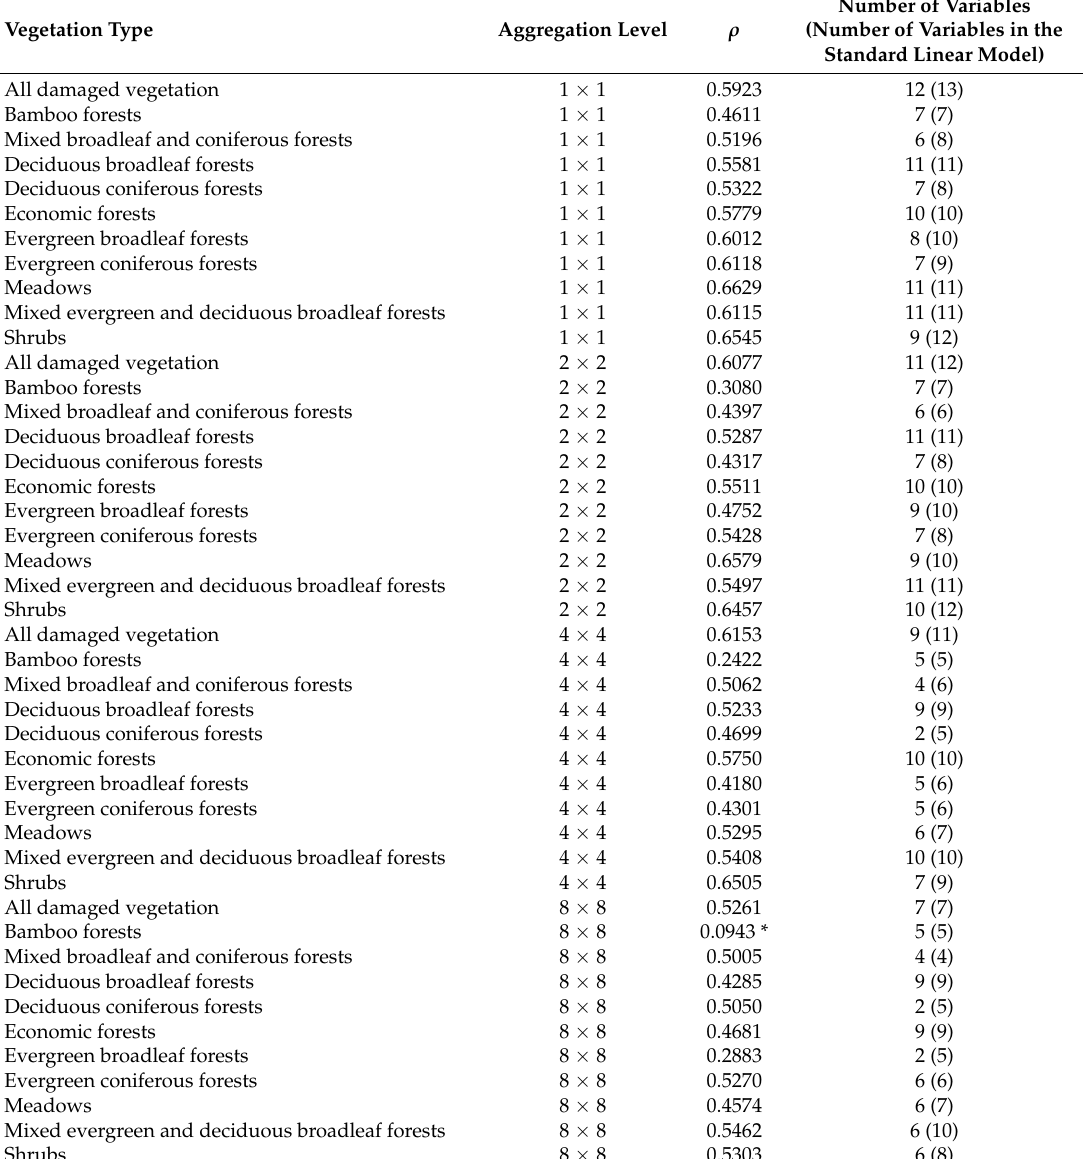
Table 9. A summary of the spatial error model for all vegetation types at four aggregation